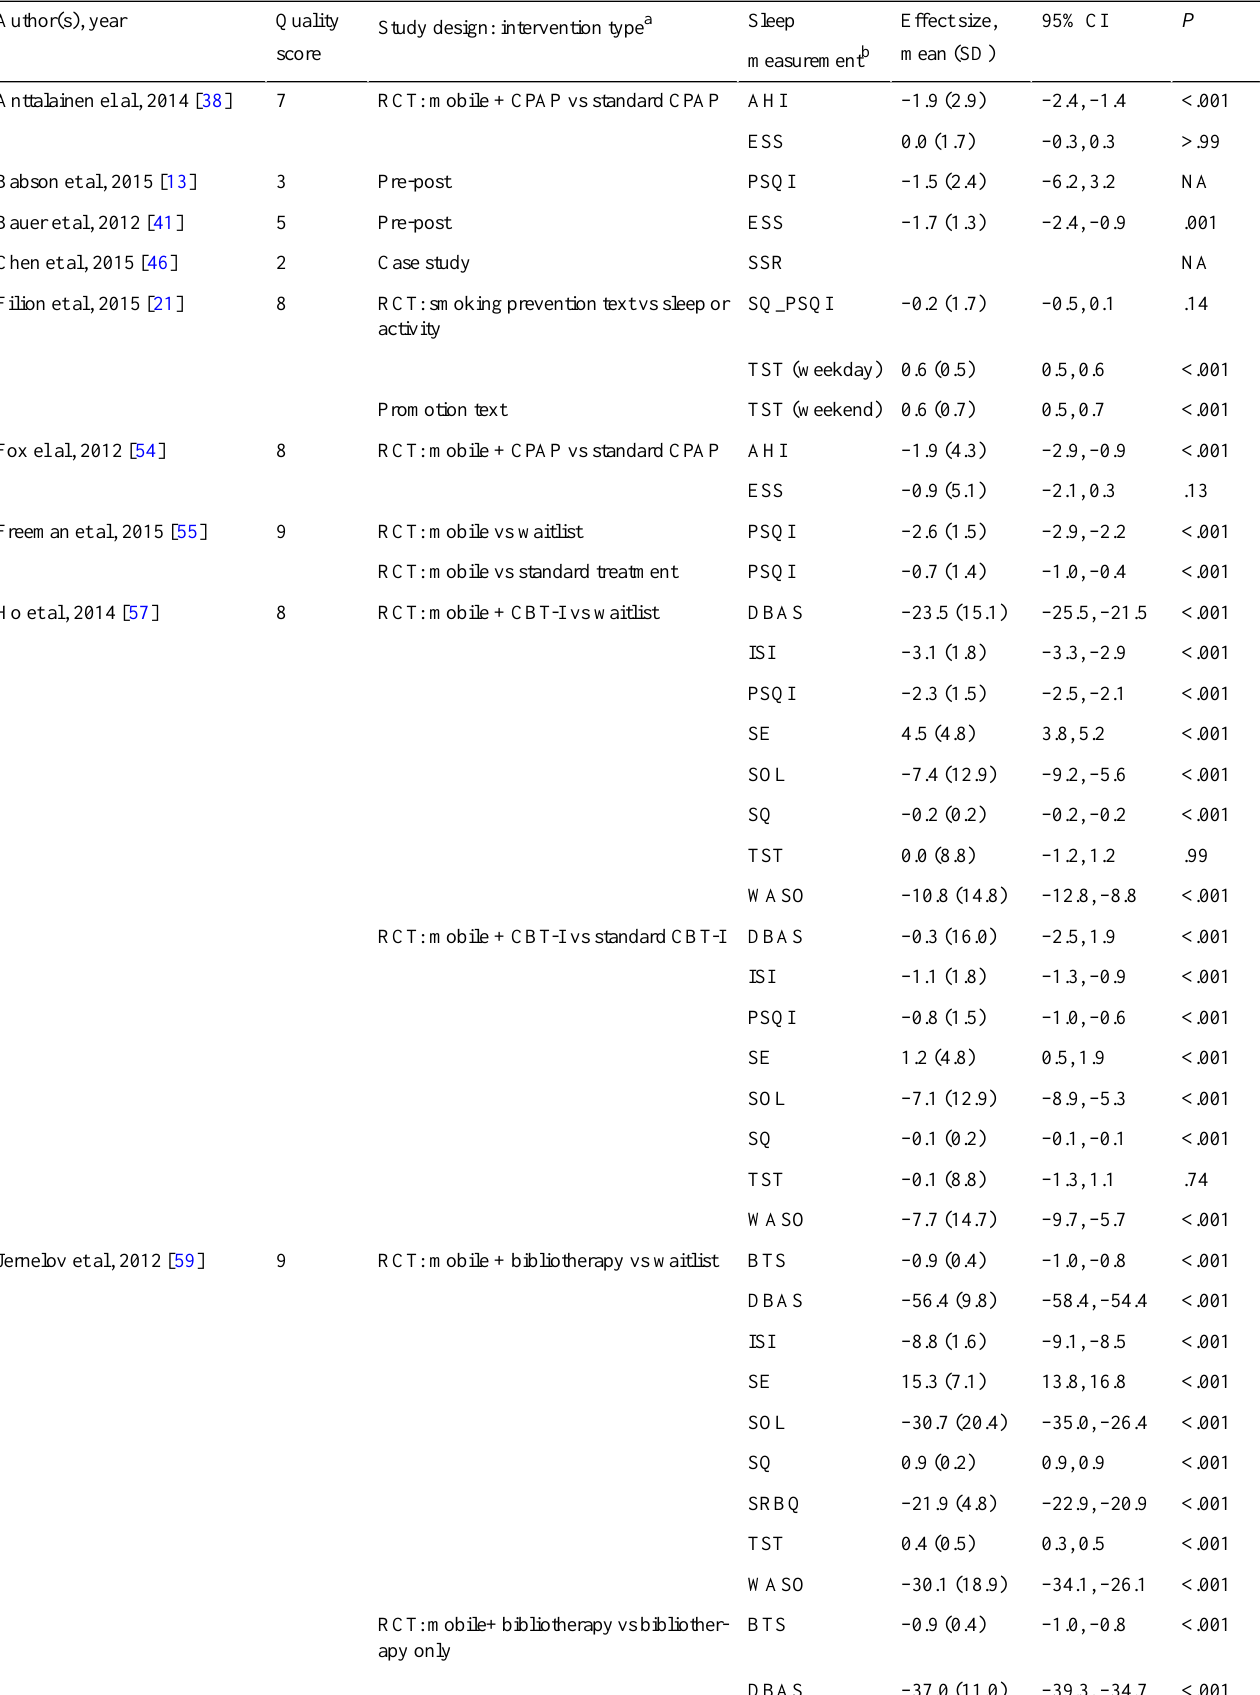
Table 3. Summary statistics: quality assessment of each journal and the effects of intervention through t test by intervention type and sleep outcome